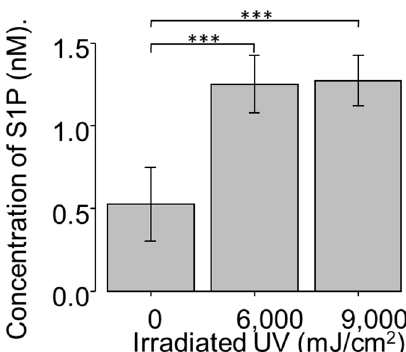
Figure 2. S1P (Sphingosine 1 phosphate) concentration of UV-NCFC (normal conjunctival fibroblast cells irradiated with ultraviolet) lysate ( n = 4). S1P concentration of cell lysate was significantly upregulated after UV irradiation at 6000 and 9000 mJ/cm 2 . *** p < 0.001 .